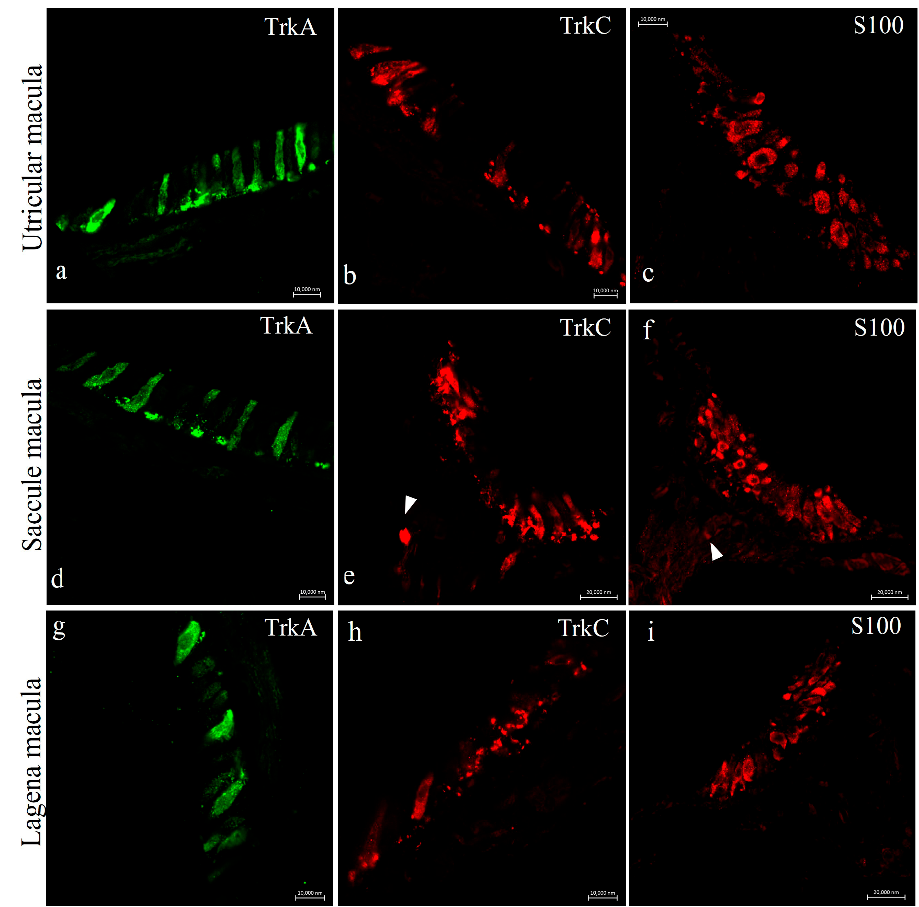
Figure 5. N.guentheri inner ear; transversal view. Immunohistochemical detection (immunofluores- cence method) of Trka protein in the macula of the utricle ( a ), saccule ( d ), and lagena ( g ), of Trkc in the macula of the utricle ( b ), saccule ( e ), and lagena ( h ). Immunohistochemical detection of S100 protein in the macula of the utricle ( c ), saccule ( f ), and lagena ( i ). The utricular and saccular maculae consist of cylindrical epithelium formed by sensory hair, supporting, mantle and basal cells. Cytoplasmatic immunoreactivity for these antibodies was found in the sensory epithelial cells of the utriculus, sacculus, and lagena. Arrowheads ( e, f ) indicate nerves. Magnification 63X ( a,b,c,d,g,h ); 40X ( e,f,i ). An immunoreactivity for TrkA, TrkC, and S100 proteins was detected in the cristae ampullaris of the semicircular canals. In a subpopulation of hair cells, specific staining was respectively detected in the central and peripheral parts of the sensory cell cluster (Figure